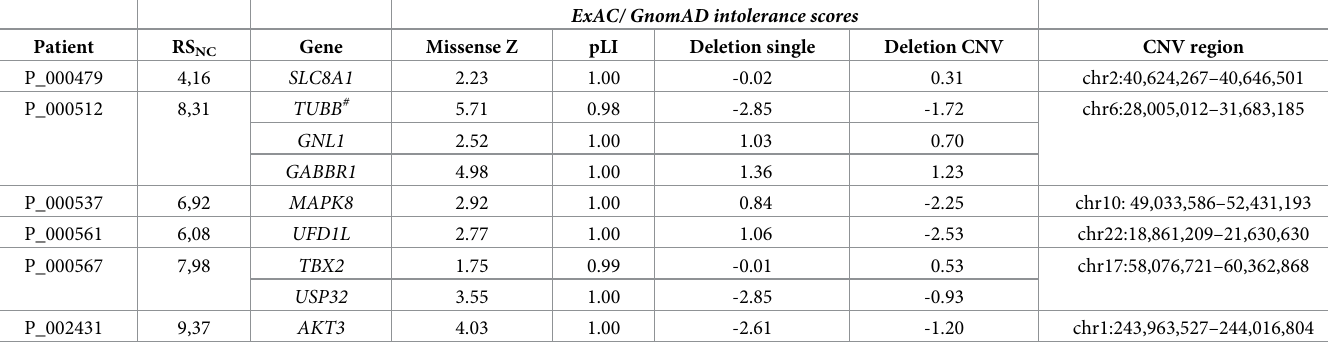
ExAC/ GnomAD intolerance scores